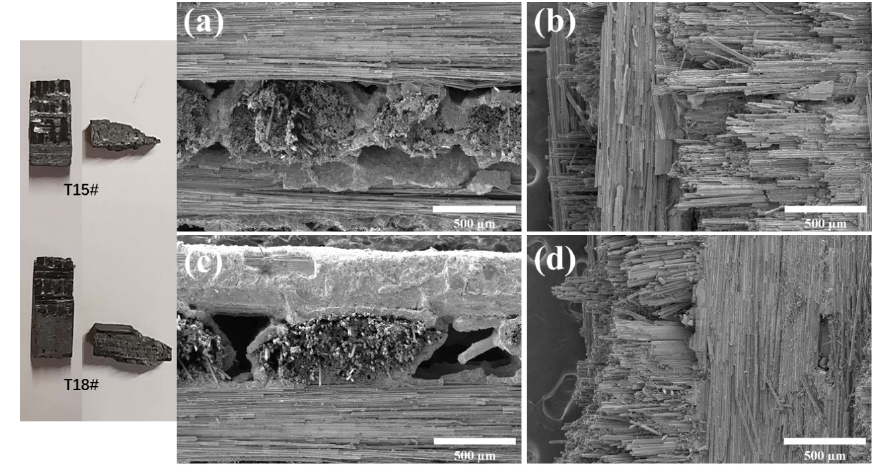
Fig. 13 Photographs and microstructures of the fractured surfaces of samples T15# and